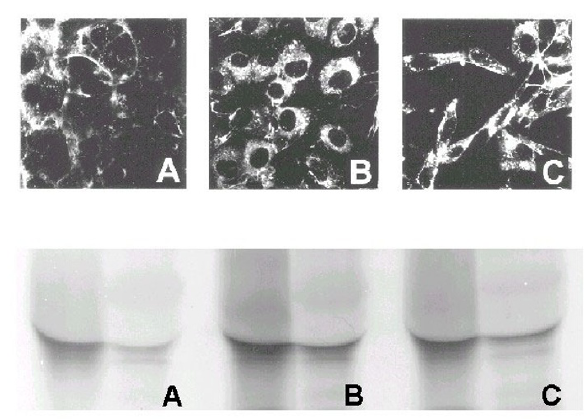
Figure 4 Subcellular localization of Cx43. MC3T3-E1 cells were treated with A. PBS vehicle (control), B. BMP-2, or C. TGF- β 1 for 48 h. Immunofluorescent localization of Cx43 visual- ized with epifluorescence microscopy (top panel). Immuno- precipitation of Cx43 in cytosolic (left lanes) and membranous (right lanes)